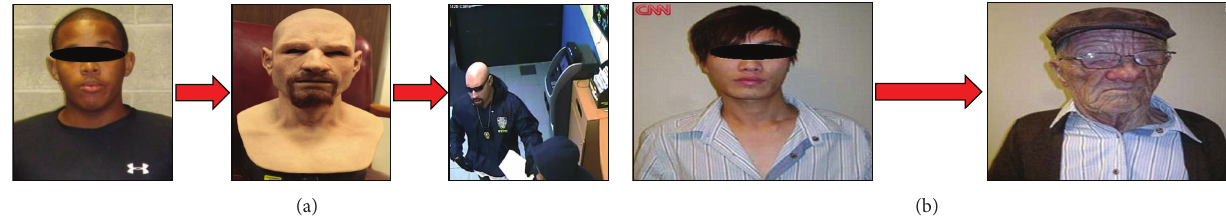
Figure 1: (a) In New York, a robber disguised as white cop using latex masks robbing a cash-checking store. (b) In 2010, a passenger boarded a plane in Hong Kong with an old man mask and arrived in Canada to claim